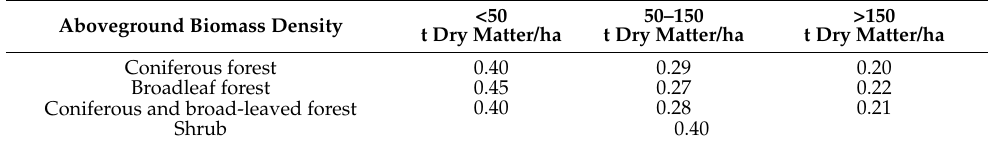
Table 1. Ratio of belowground biomass to aboveground biomass